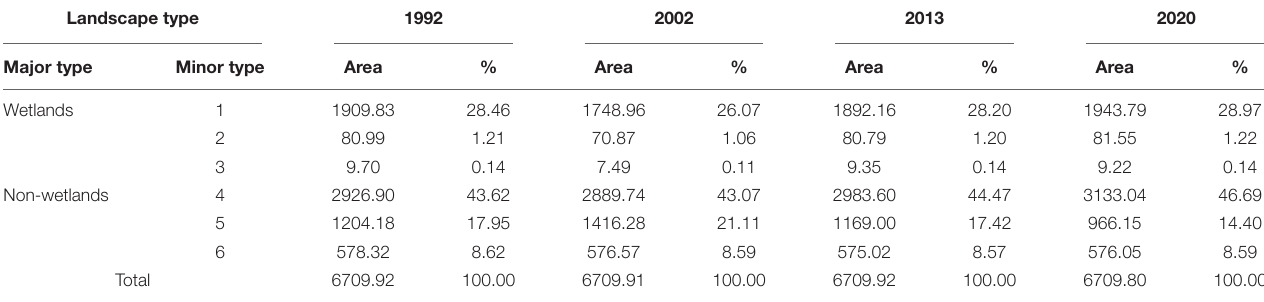
TABLE 4 | Area (km 2 ) and percentage (%) of various landscape classes at the Changshagongma Wetland Nature Reserve during the four time periods. Landscape